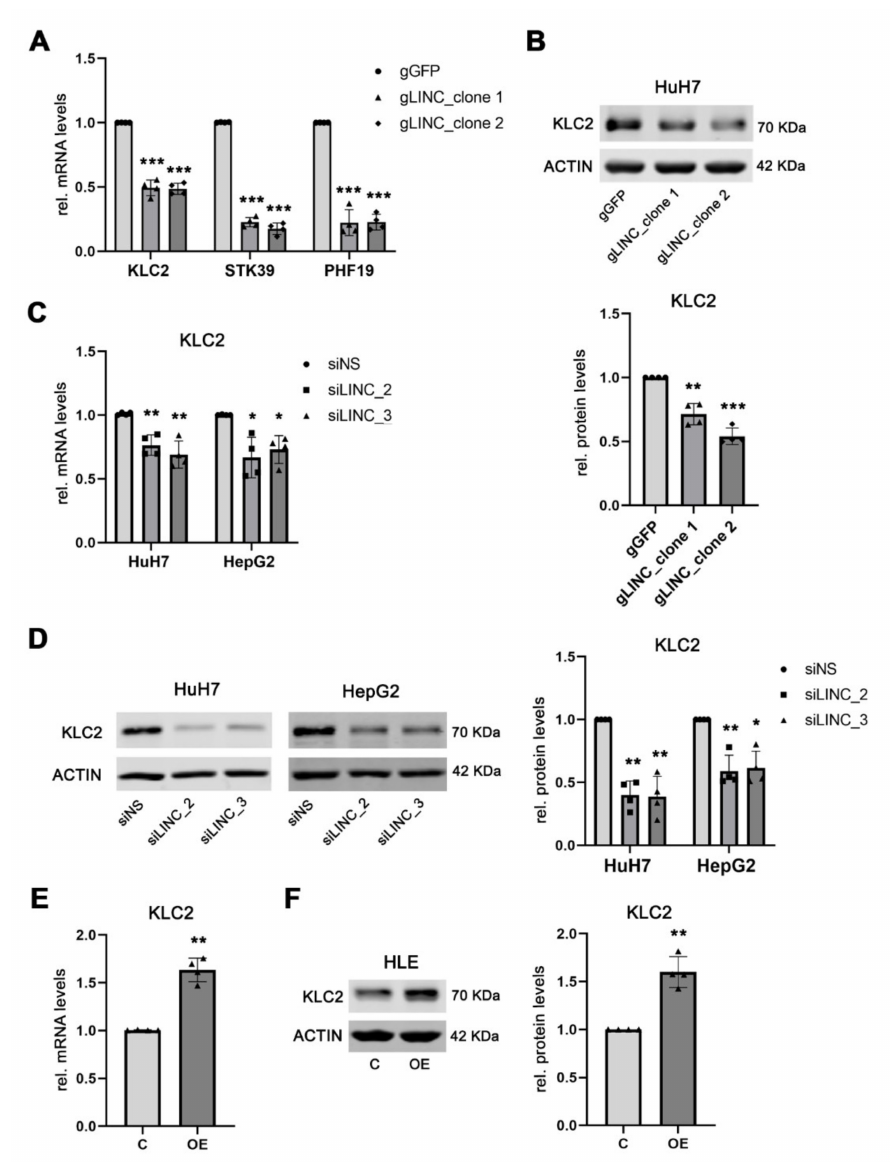
Figure 3. KLC2 belongs to the target genes of the LINC00152 -driven ceRNA network. ( A ) KLC2 , STK39 and PHF19 are significantly downregulated in HuH7 ∆ LINC00152 compared to HuH7